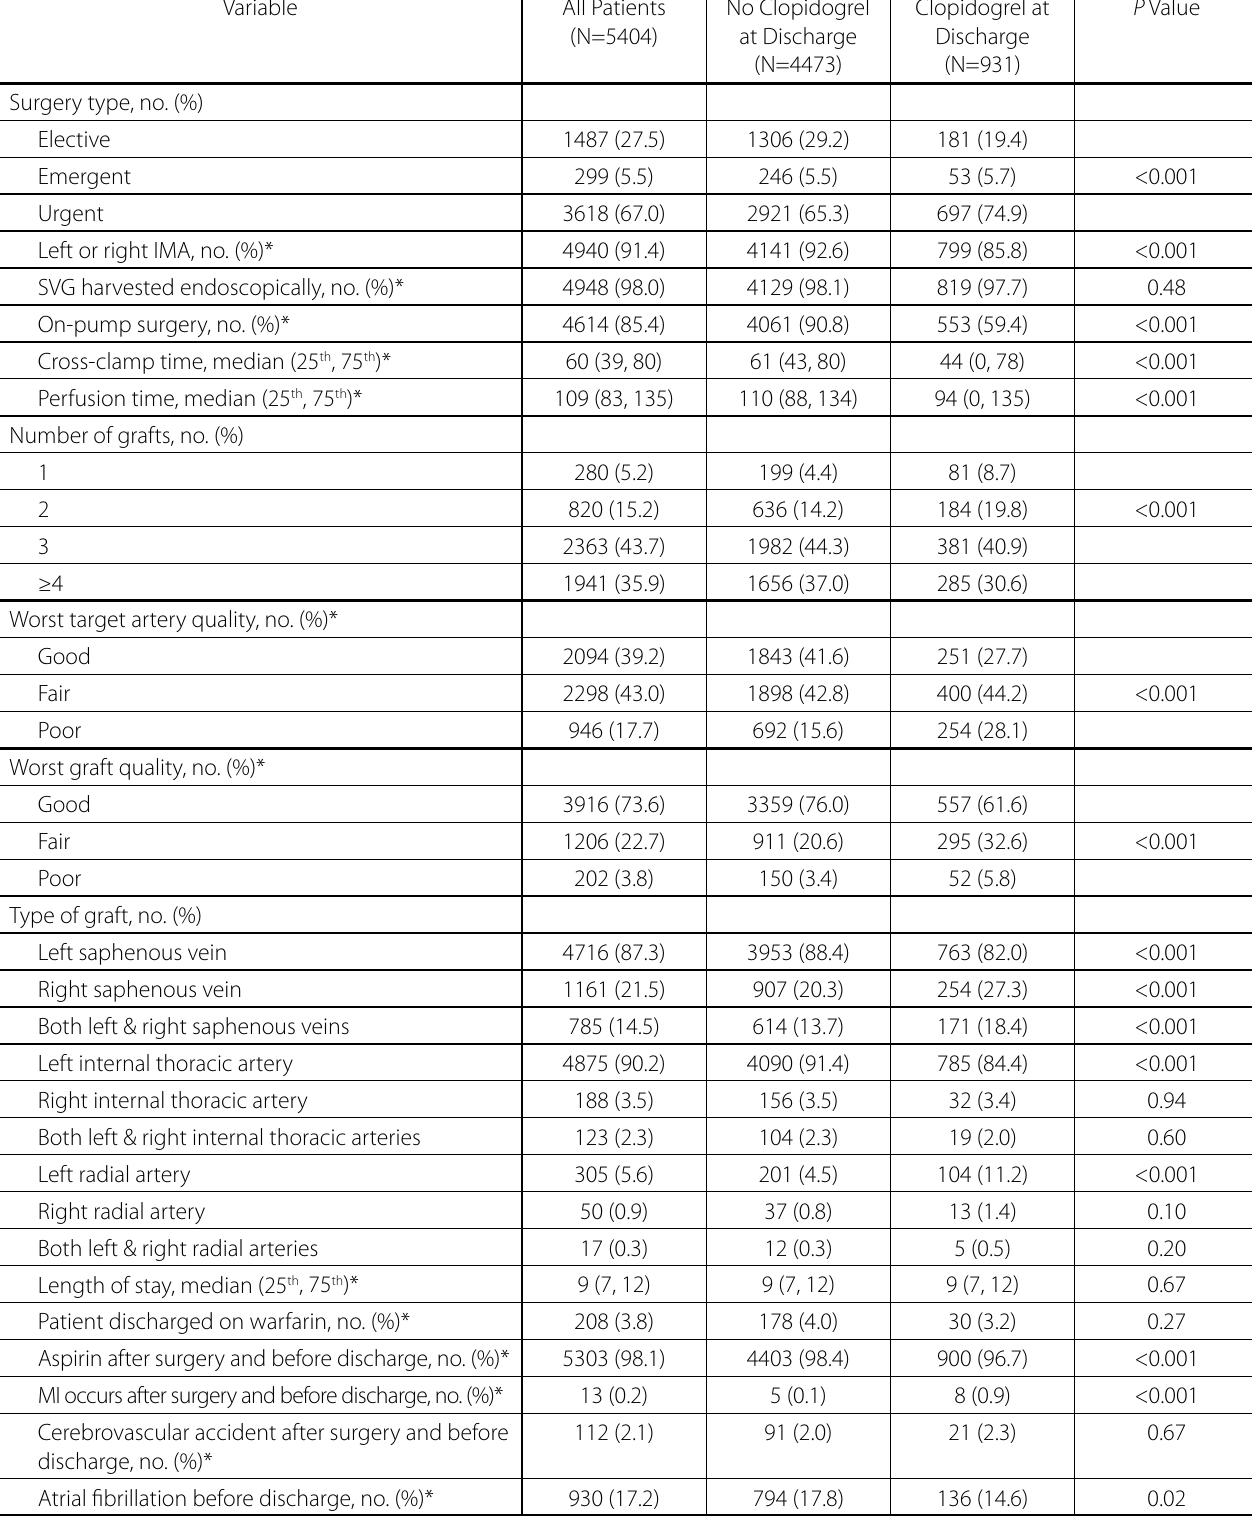
Table 2. Operative and postoperative characteristics according to clopidogrel use after CABG.